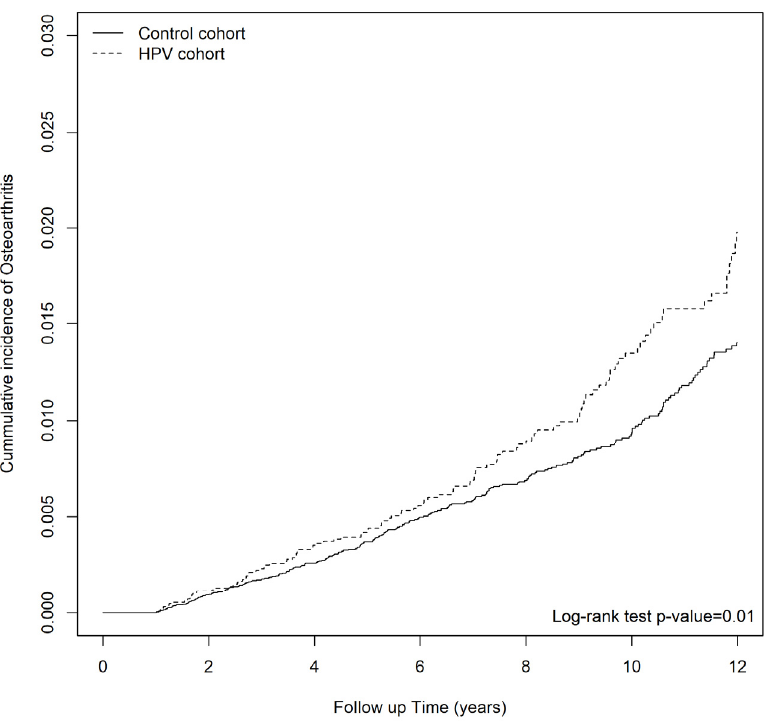
Figure 1. Kaplan-Meier curves for the cumulative incidence of new-onset osteoporosis in individuals with or without human papillomavirus infections. Table 2. Factors associated with a diagnosis of osteoporosis in the Cox proportional hazard models. Osteoporosis